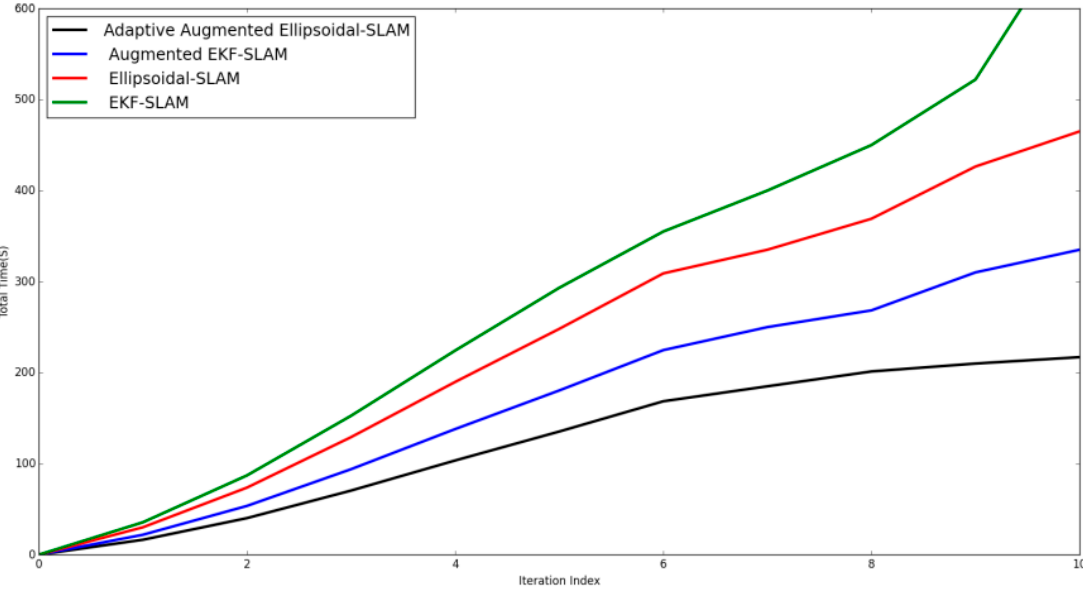
Figure 21. The RMS errors of the NAO heading of the implemented SLAM.